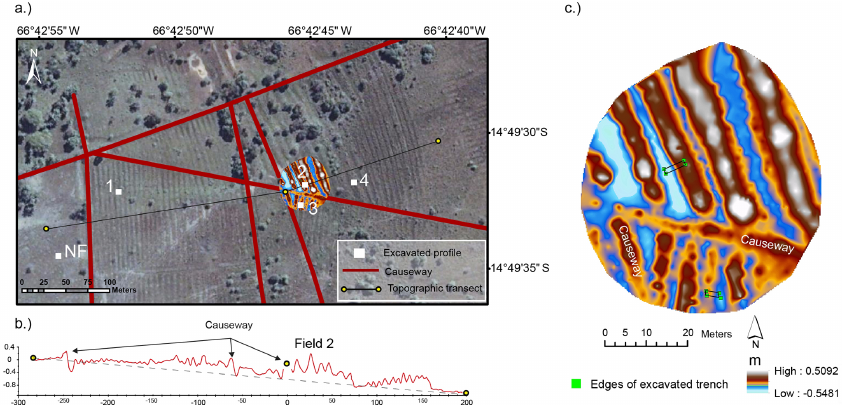
Figure 5. (a) Study area including causeways and excavation sites. (b) Topographic transect going from west to east. (c) Digital elevation model present-day morphology covering Field 2 and